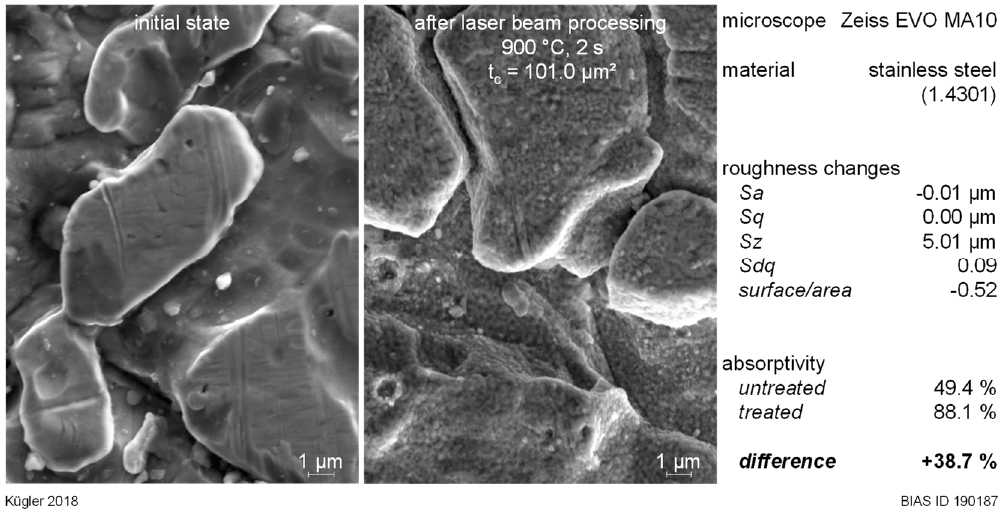
Figure 11. Visualization (secondary electron-scanning electron microscopy (SE-SEM)) of the oxide layer formation due to laser beam heating.